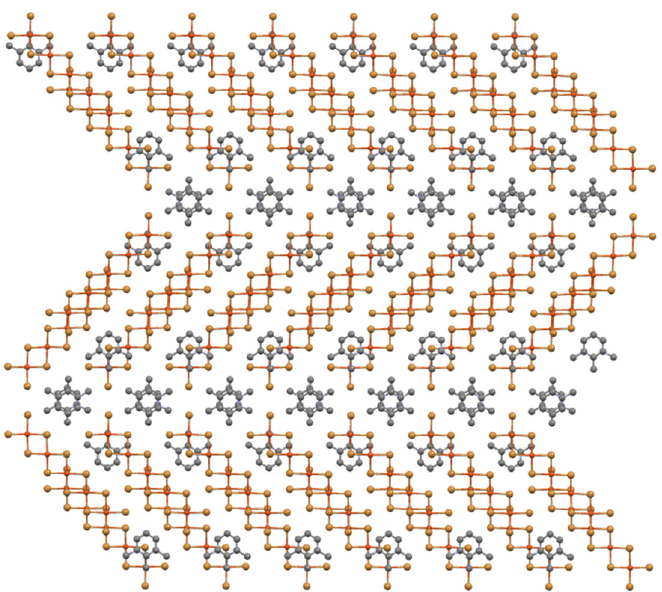
Figure 8. Ball-and-stick diagram of alternate stacking of two mixed organic cation/oligomer sheets from the title structure with neighboring oligomers now parallel to one another to yield isolate 5(5/2,1/2 stacks) with “inversion-related” organic cation pairs separating layers of stacks. A triclinic unit cell can be derived for this stacking by taking the repeat vectors along each of the two stacks of differing orientation (9.578 Å) and doubling the a -axis to account for the fact that layers of oligomer stacks of the same orientation are now twice as far apart as neighboring layers in the cross-hatched structure. This unit cell has the same volume as that of the title compound but transforms to a C -centered monoclinic cell ( a = 16.3327 Å, b = 10.0115 Å, c = 20.1452 Å, and β = 82.34°). A visualization of this structure in space group C 2, with appropriate transformation of atomic coordinates from the title structure, gives quite reasonable ORTEP and unit cell packing diagrams (Figure 9). More compli- cated stacking sequences than these could also be envisioned. Figure 9. Diptych depicting the ORTEP diagram (50% ellipsoids) for the hypothetical structure ob- tained by …AAAA… stacking of mixed organic cation/oligomer sheets (left) and the unit cell pack- ing diagram (right) viewed along (110) (in the transformed unit cell) down one oligomer stack ori- entation with the other stack orientation along (1 1(cid:3364) 0). The stacks are arranged into layers along (002) separated by organic cation pairs.